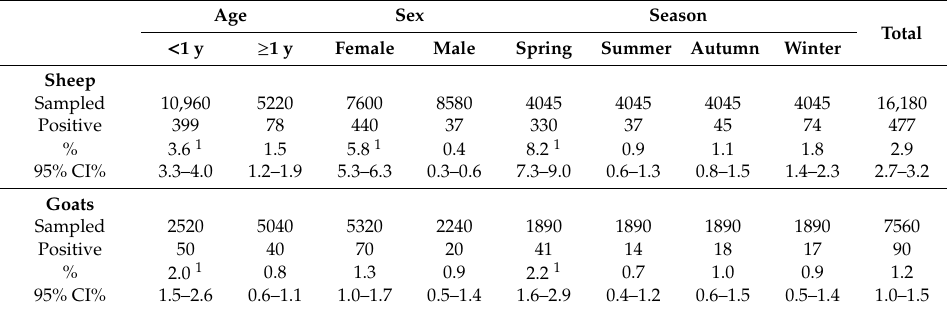
Table 1. Prevalence of Taenia ovis cysticerci in sheep and goats, by age and sex, from the Najafabad abattoir, Isfahan, Iran, 2017–2018.